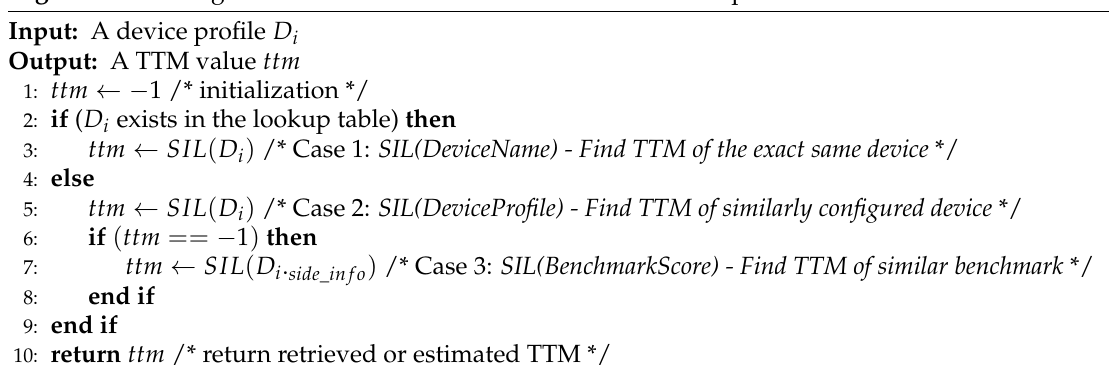
Algorithm 2 An algorithm for hierarchical side information